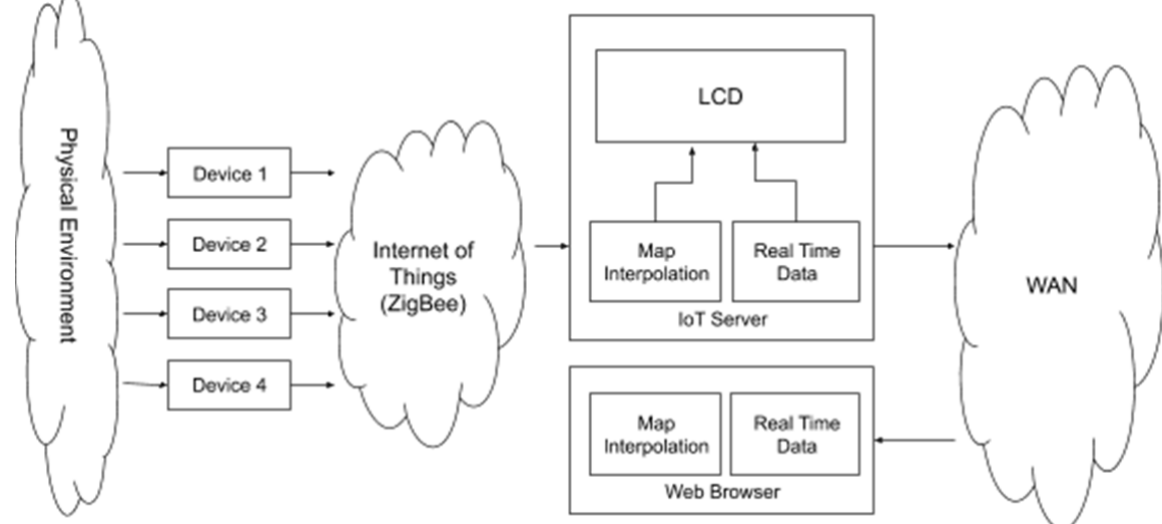
Figure 7. The general architecture of the system.